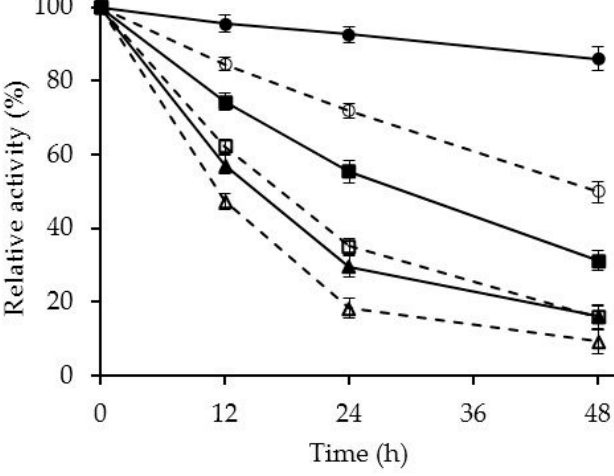
Figure 3. Effect on enzyme activity of the incubation of the immobilized CALB in the presence of different organic solvents. Enzyme preparations were incubated in mixtures of organic solvents/100 mM Tris-HCl pH 7 at 40 °C. Solid line: OCCALB-PEI biocatalyst; dashed line: OCCALB biocatalyst; circles: 80% 1,4-dioxane; squares: 45% acetonitrile; triangles: 70% ethanol.